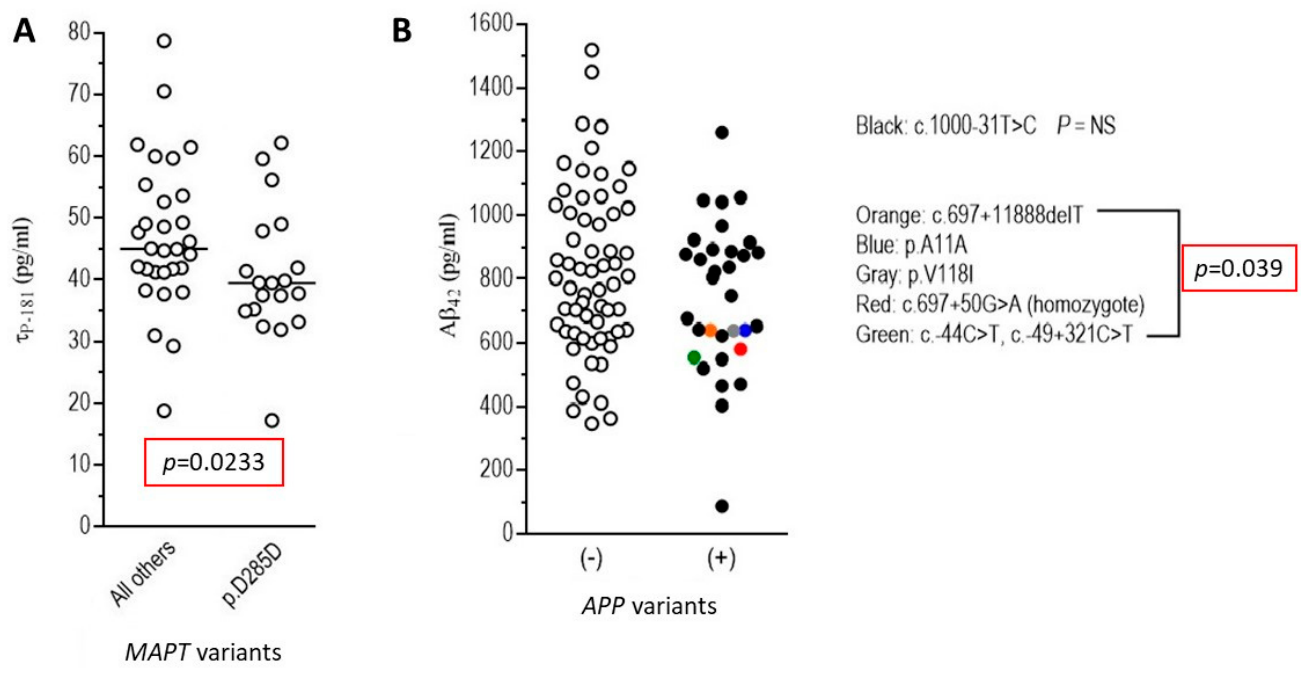
Figure 4. Association of MAPT and APP gene variants with CSF biomarkers (A β 42 , τ T , τ p-181 , TDP-43) in the entire cohort of FTD and/or ALS patients. ( A ) As shown here, the c.855C>T (p.Asp285Asp/p.D285D) MAPT synonymous variant carriers had significantly lower τ p-181 levels compared to non-carriers; ( B ) carriers of rare APP variants (p.Ala11Ala/p.A11A, p.Val118Ile/p.V118I, c.-44C>T/c.-49+321C>T, c.697+50G>A and c.697+11888delT) had lower A β 42 levels. These lower A β 42 levels were not found for the more common intronic variant